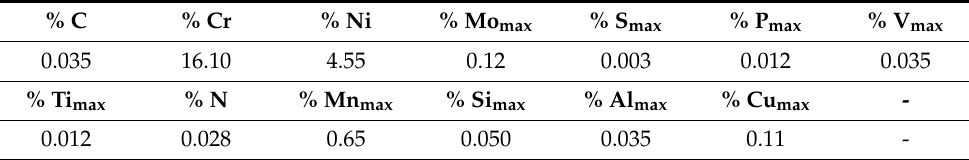
Table 1. Chemical composition of analyzed 16Cr5NiMo steels.